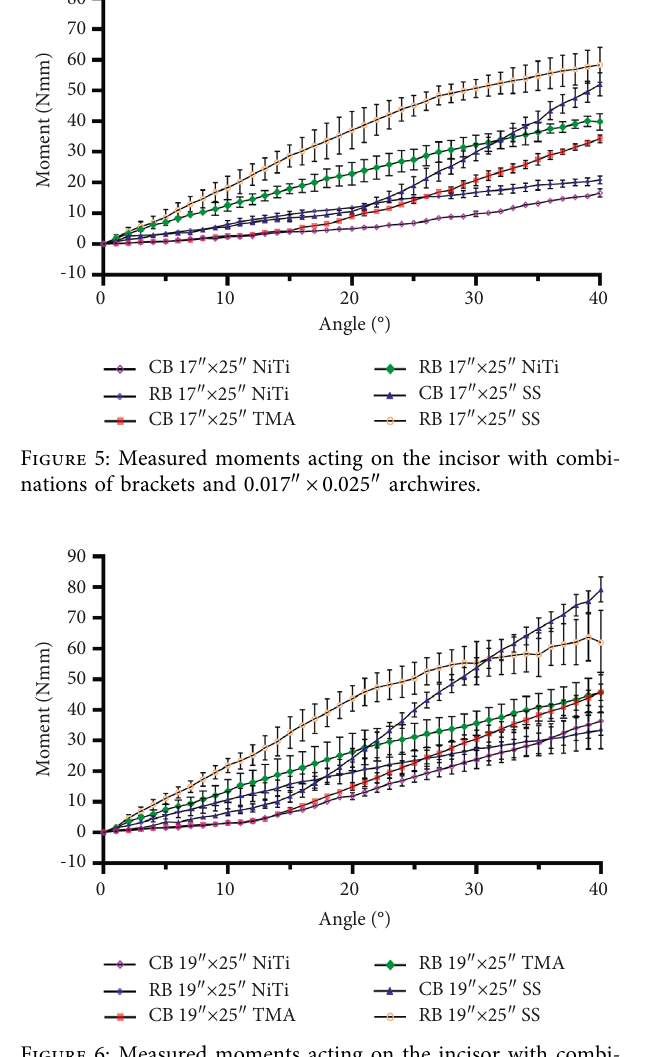
Figure 6: Measured moments acting on the incisor with combi- nations of brackets and 0.019